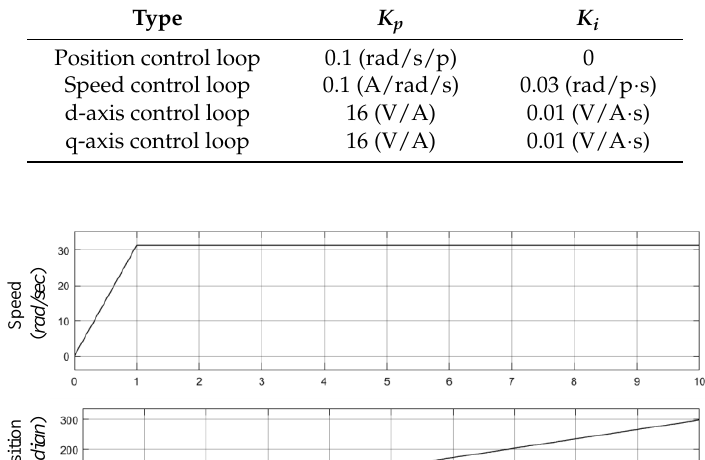
Figure 8. The speed and position responses by pulse generator.